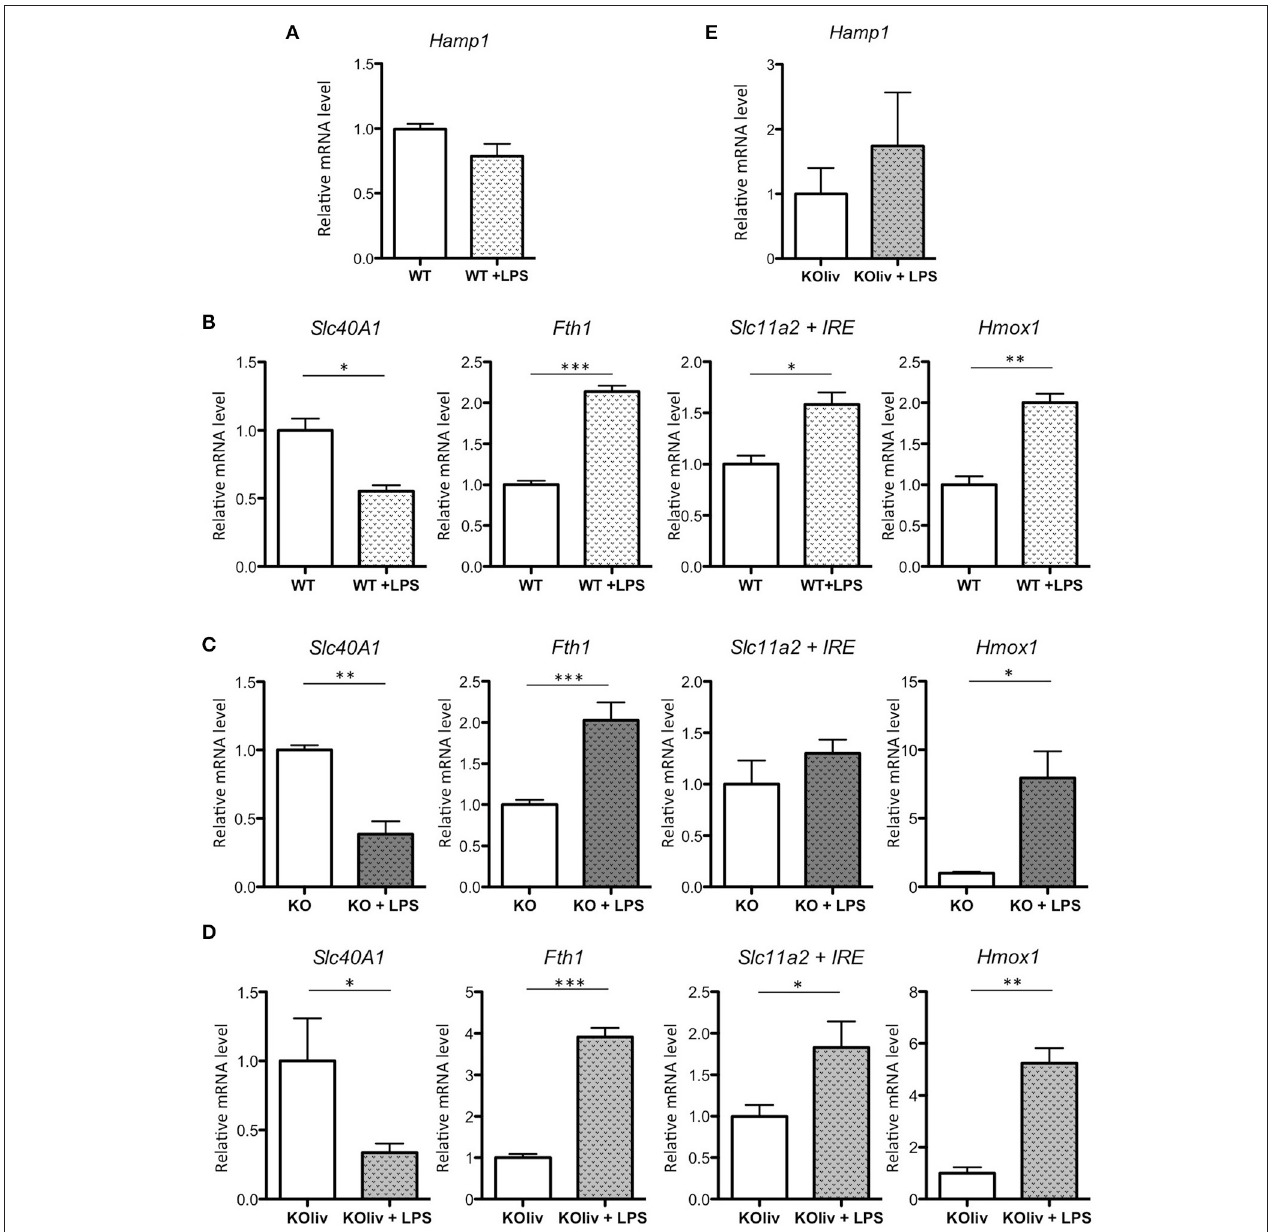
FIGURE 6 | LPS responses in the lung of WT, Hepc KO and Hepc KOliv mice: Hamp (A) , as well as Slc40A1 , Fth1 , Slc11a2 + IRE, and Hmox1 mRNA levels relative to Ppia , analyzed by real-time PCR in the lung of WT mice (B) , Hepc KO mice (C) or Hepc KOliv (D) mice IP injected for 6h by LPS. Changes are expressed relative to untreated WT or KO mice, respectively. Hamp (E) , relative to Ppia , in the lung of Hepc KOliv mice IP injected for 6h by LPS. This set of results were reproduced using another serie of WT and Hepc KO mice. Error bars represent SEM for n = 3–4 mice in each group. Statistical significance is indicated by asterisks (* p < 0.05, ** p < 0.01, *** p <